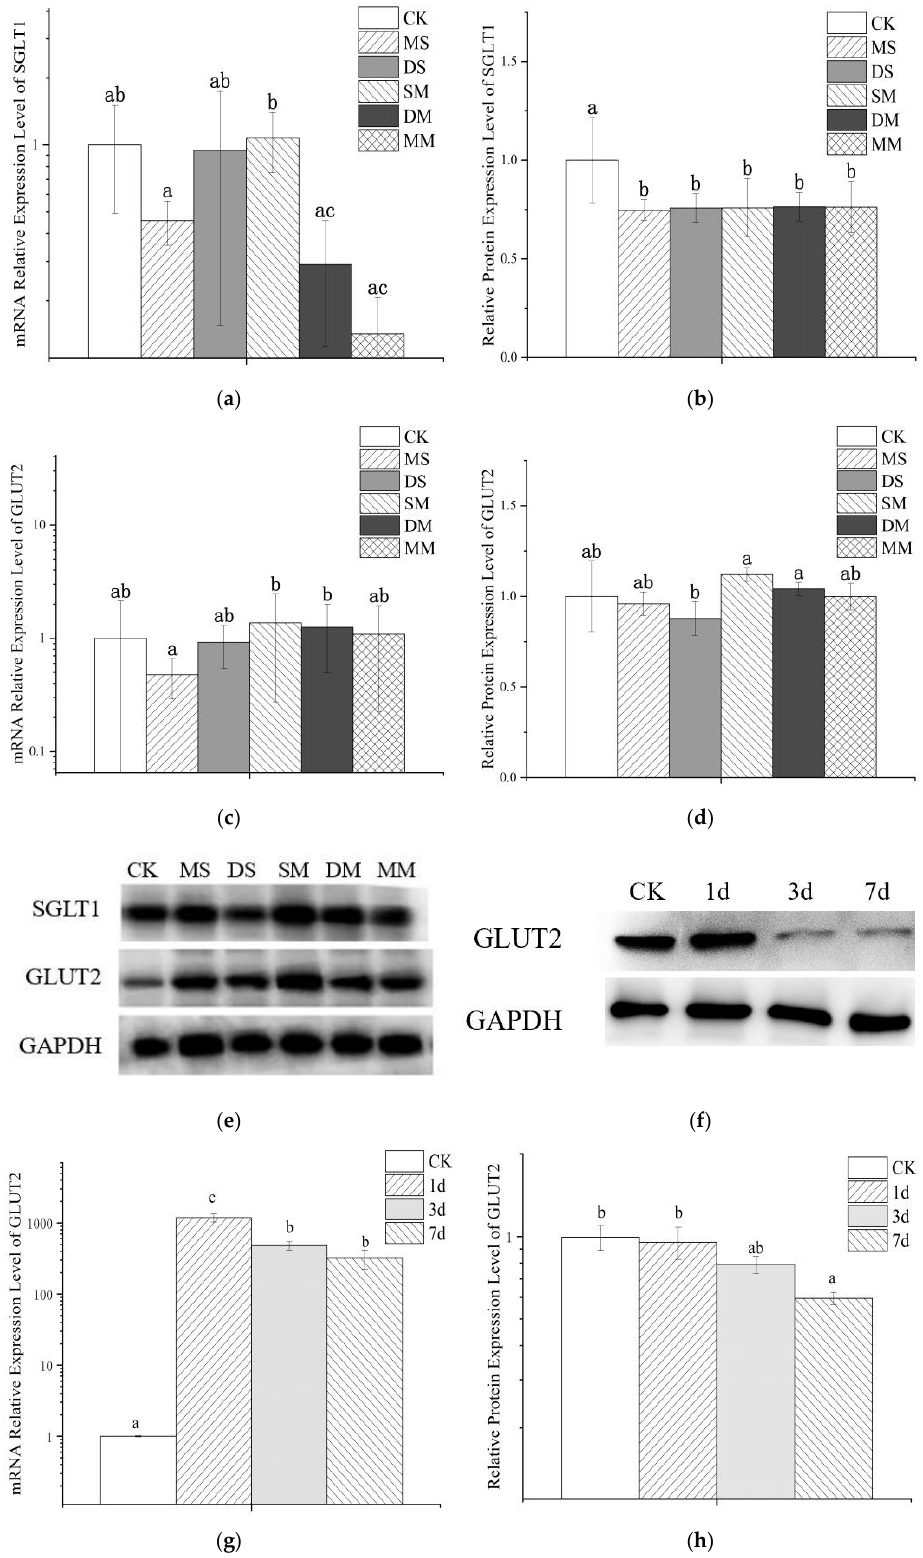
Figure 5. Effects of anthocyanins on mRNA and the expression of SGLT1 and GLUT2 during transport. ( a ) mRNA relative expression level of SGLT1; ( b ) relative protein expression level of SGLT1; ( c ) mRNA relative expression level of GLUT2; ( d ) relative protein expression level of GLUT2; ( e ) Western